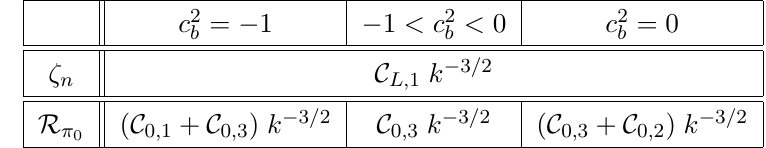
Table 3. Inside the region of flat PS ( − 1 ≤ c 2